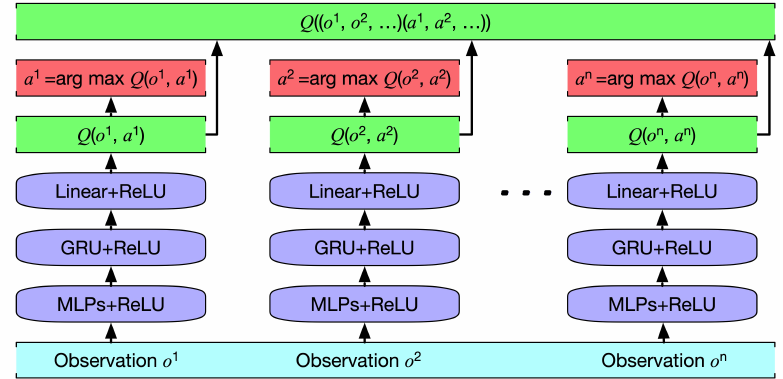
Figure 3. Architecture of neural networks used in the MARL